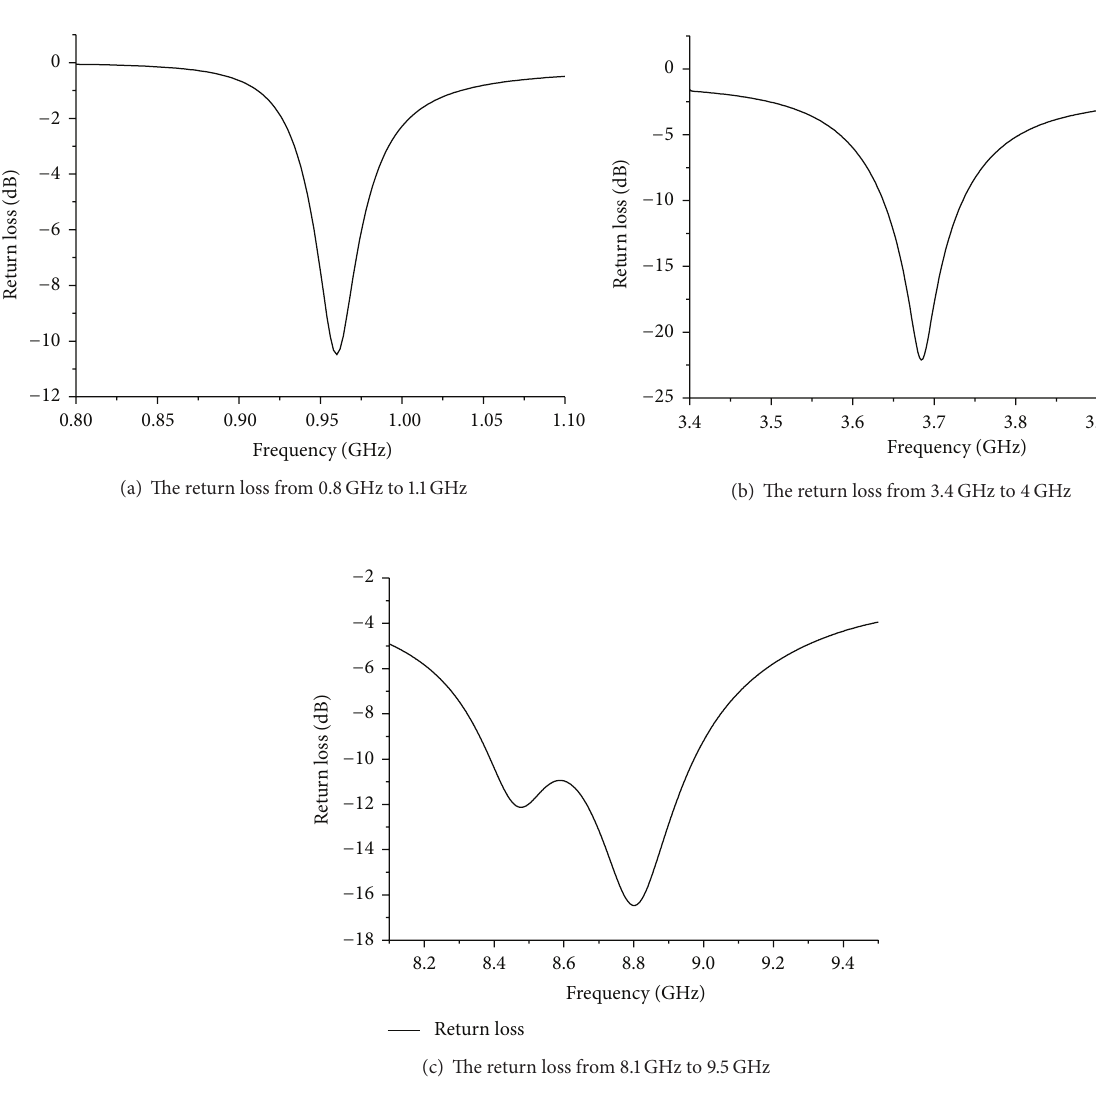
Figure 3: The return loss of the proposed antenna. (a) The return loss from 0.9GHz to 1.1GHz. (b) The return loss from 3.5 GHz to 3.9 GHz. (c) The return loss from 8GHz to 9.1